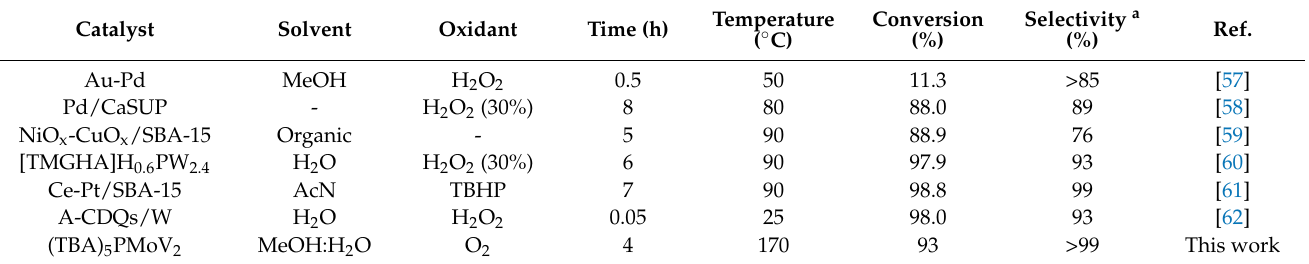
Table 3. Catalytic performance in the oxidation of benzyl alcohol for various